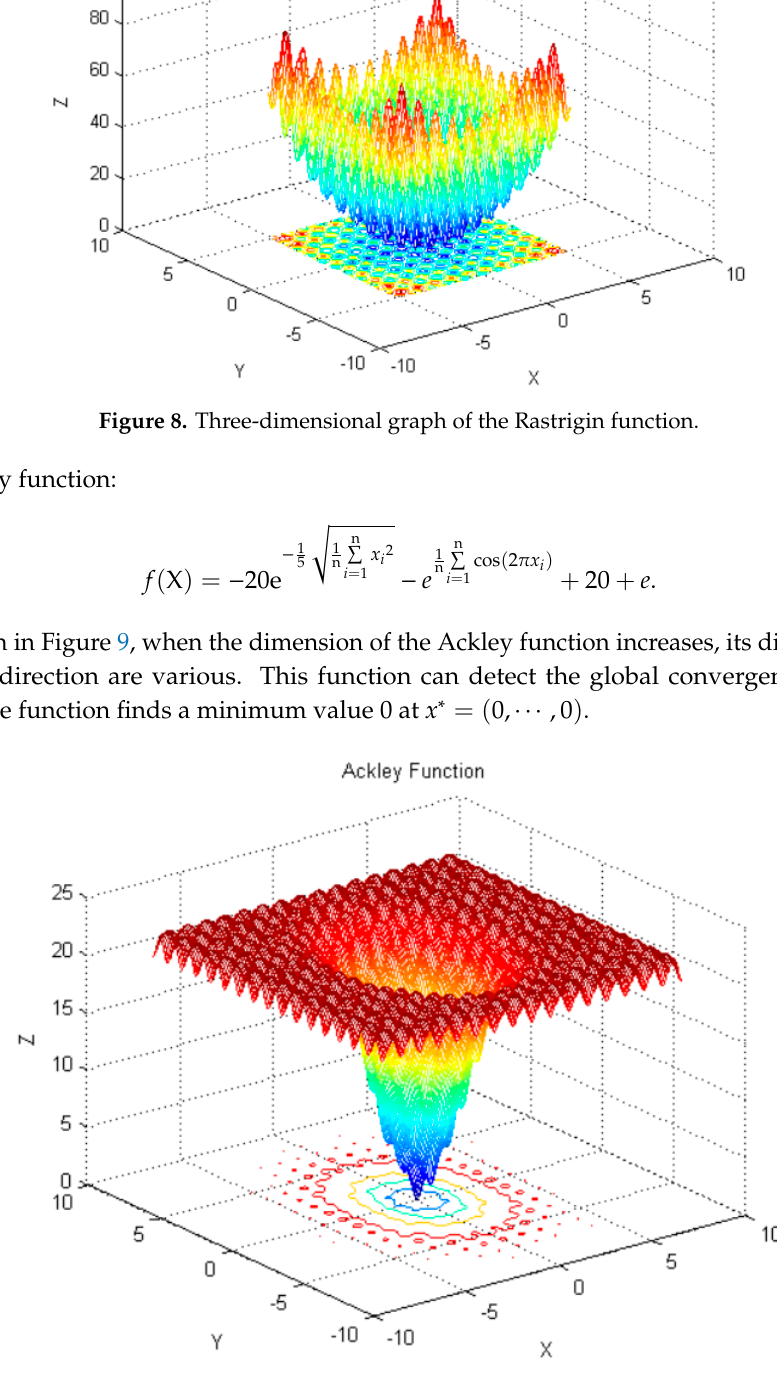
Figure 9. Three-dimensional graph of the Ackley function.